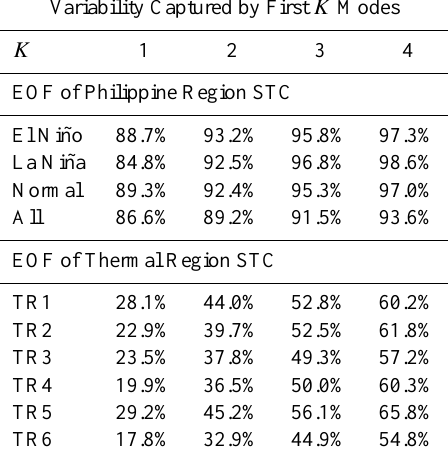
Fig. 10. The STC over 21 years ( s = 3 ,c = 3 ,j = 2, overlapping time-slices) together with the time-dependent amplitudes of first four EOF modes ( a–d ) of the SST. The STC and the time-dependent amplitudes of the SST were mean-centered and divided by their maxima. El Ni˜no years are highlighted in blue, La Ni˜na in red and normal years in green. Table 3. The percentage of the variability of the set captured by the first four EOF modes for the Philippine region STC during the El Ni˜no, La Ni˜na and Normal years (top) and for each of the thermal regions (bottom). For El Ni˜no and La Ni˜na, all strong, moderate and weak ENSO years were used. STC parameters: s = 3, c = 3 and moving average threshold j =